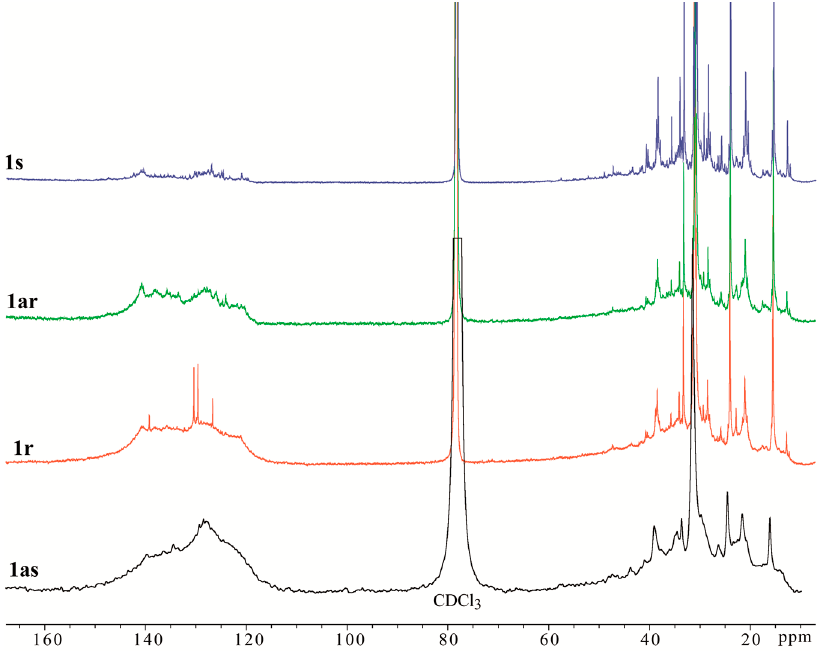
Figure 2. 13 C (175 MHz) NMR spectra of oil samples 1s–1as (s—saturated compounds, ar—aromatics, r—resins, as—asphaltene fraction). Table 5. Molar fractions (%) of primary (C p ), secondary and quaternary (C sq ), tertiary (C t ), aromatic (C ar ) groups, aromaticity factor (F CA ), and mean chain length (MCL) of aliphatic hydrocarbons based on 13 C NMR spectra of samples 1, 1s–1as.